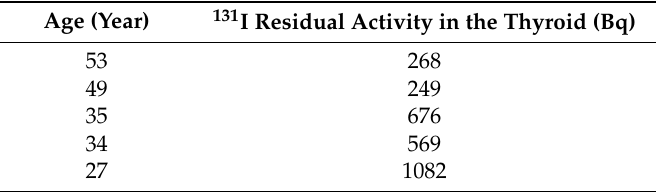
Table 1. The 131 I residual activities in the thyroid to be preserved in estimations.